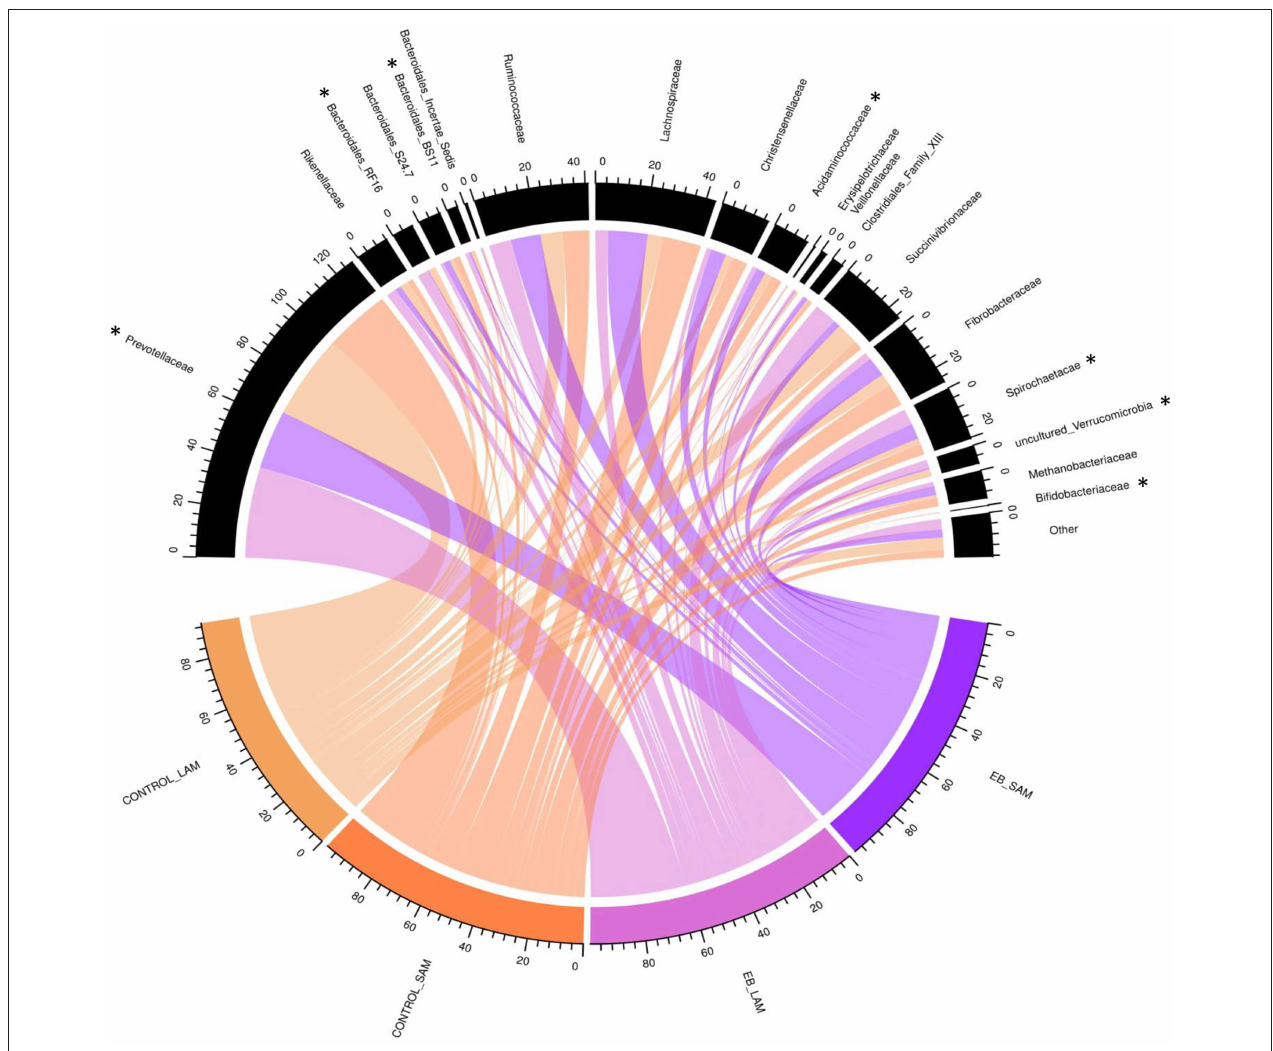
FIGURE 2 | Chord diagram displaying the relative abundance (%) of families associated with treatment (Control and 2.0% enhanced biochar) and source (SAM, solid associated microbes; LAM, liquid associated microbes). The scale indicates total accumulative abundance. The width of each chord represents the relative abundance of each family that is associated with each treatment and source. Family with *indicate those with significant